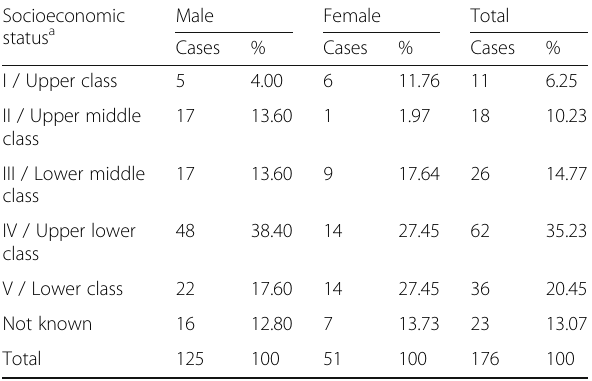
Table 3 Distribution of drowning deaths as per socioeconomic